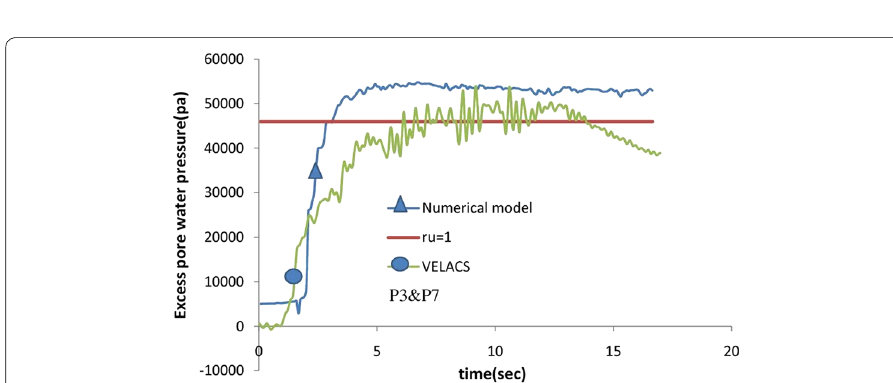
Fig. 6 Comparison of excess pore water pressure values at depth of 5 m